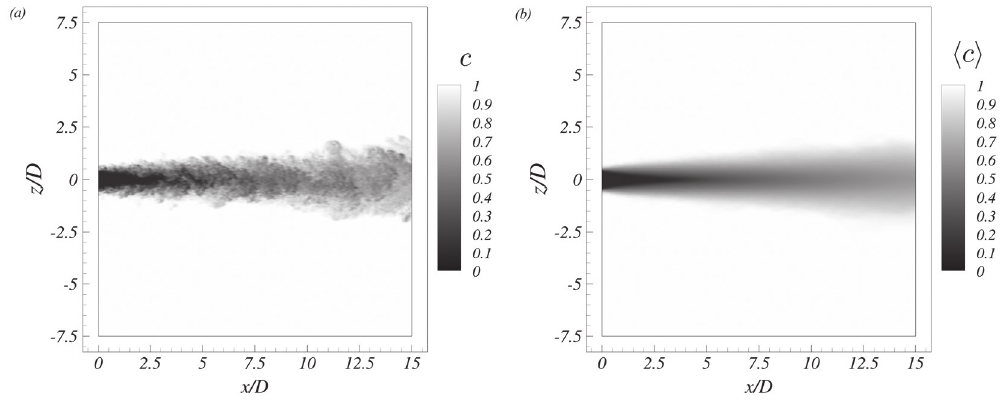
Figure 8 - Scalar variable c for the cold jet: instantaneous (a) and averaged (b)